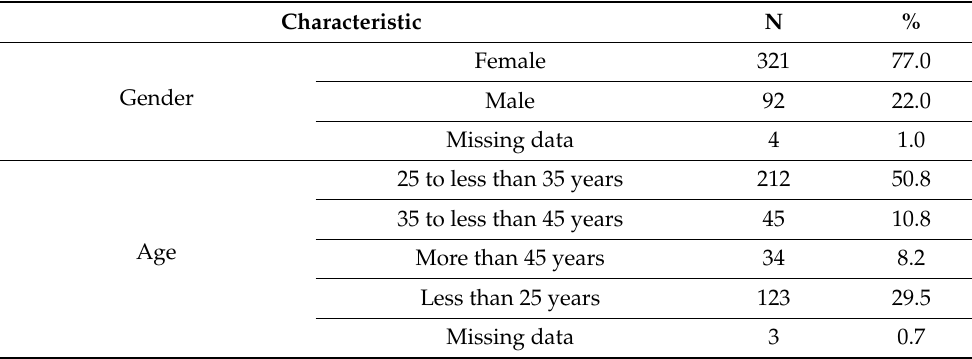
Table 1. Socio-demographic characteristics of the participants (N =